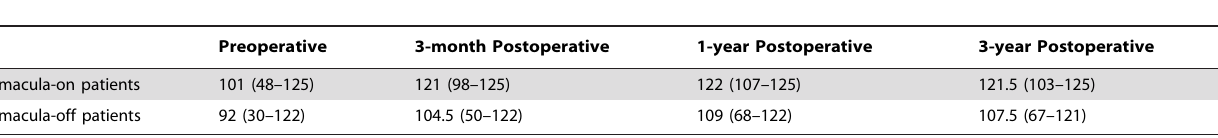
*CLVQOL: Chinese-version Low Vision Quality of Life Questionnaire, RRD: rhegmatogenous retinal detachment. doi:10.1371/journal.pone.0028597.t003 PLoS ONE |